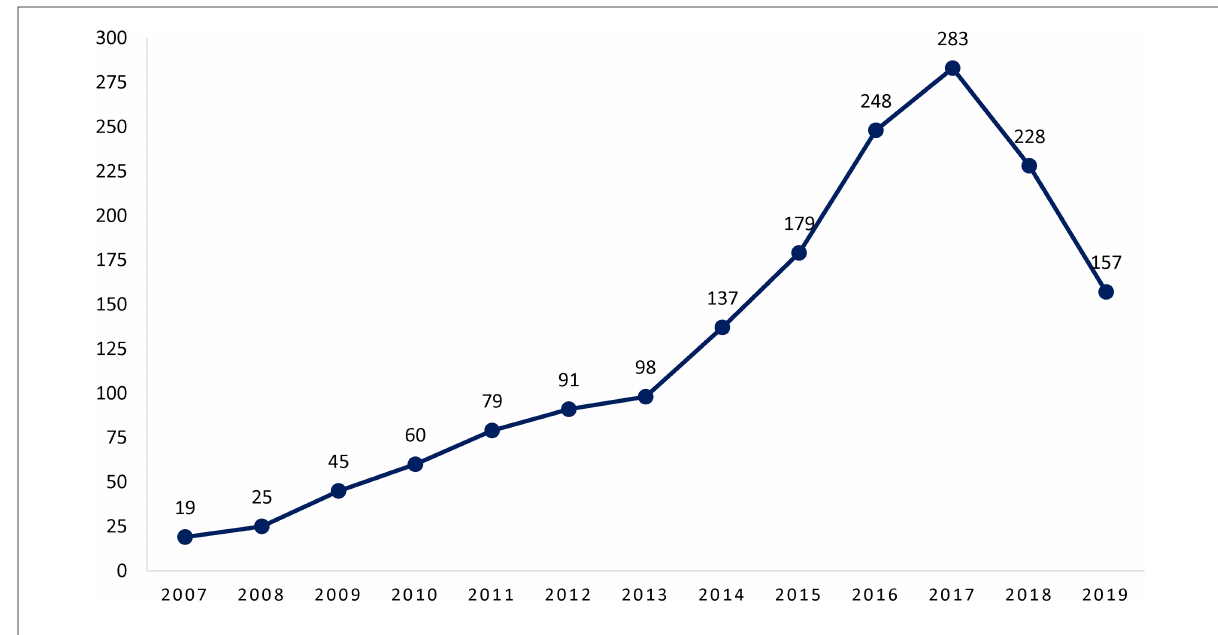
FIGURE 1 Yearly incidence of the KD in 100,000 populations <18 years from 2007 to 2019.